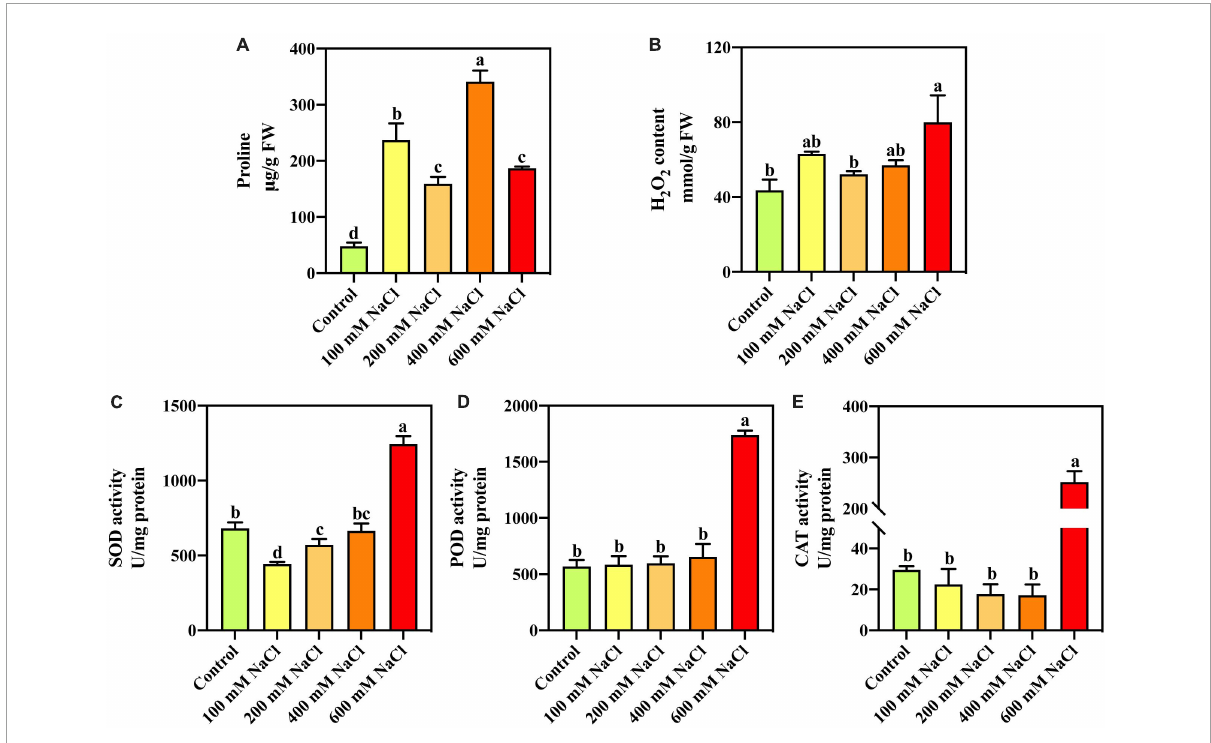
FIGURE1 The proline (A) , H 2 O 2 content (B) , and activities of SOD (C) , POD (D) , and CAT (E) in the leaves of S. portulacastrum under salt stress.